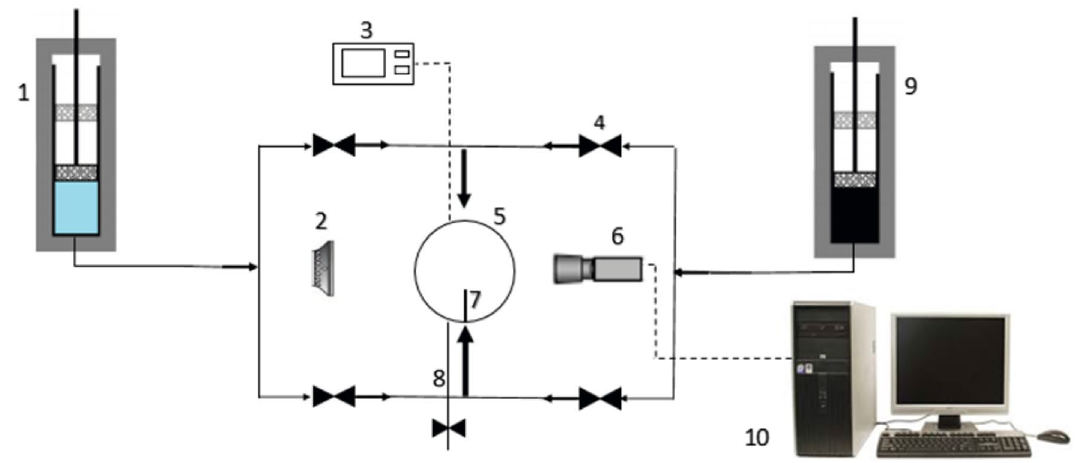
Fig. 4 Schematic of the IFT400. 1: Bulk flow pump. 2: Light source. 3: Indicator and regulator of temperature and pressure. 4: High-pres- sure valve. 5: Cell 6: Camera. 7: Metal needle. 8: Discharge line. 9: